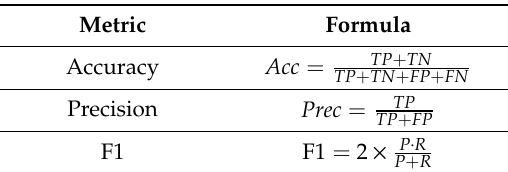
Table 3. Metrics.